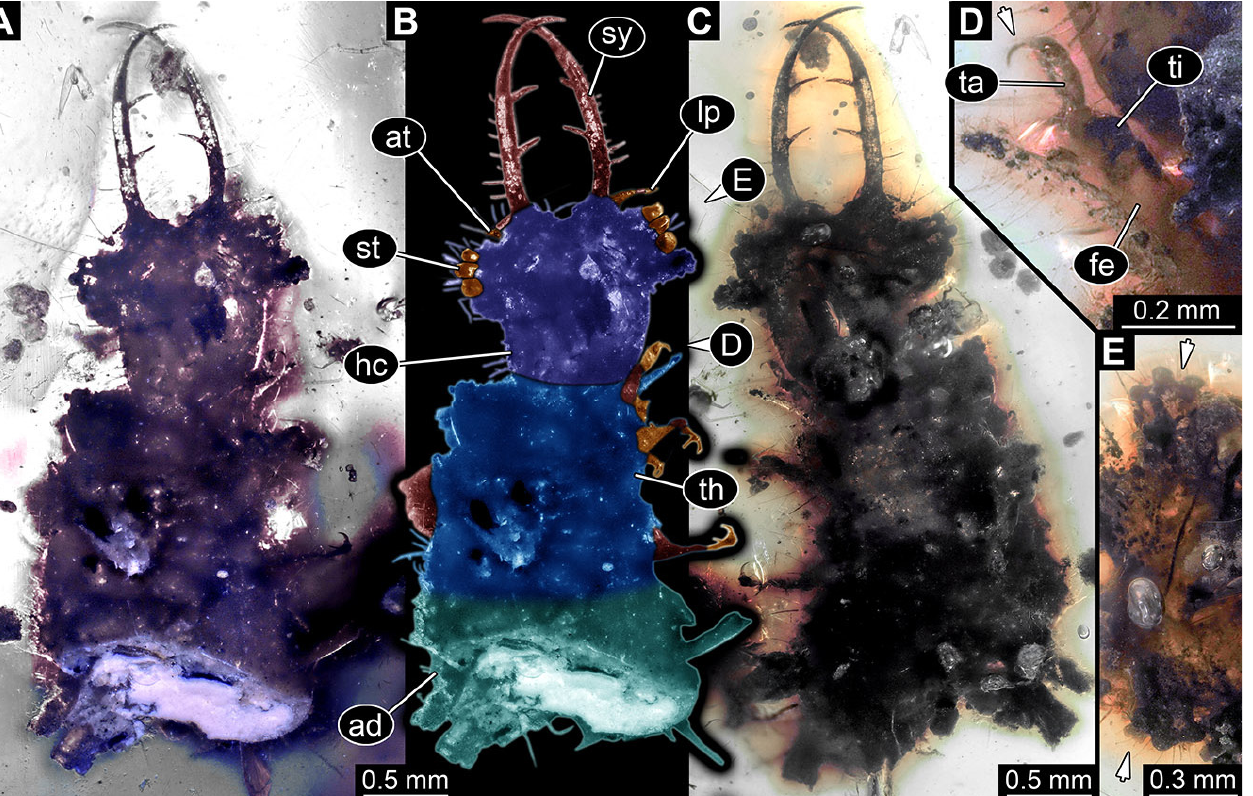
Figure 19. Fossil owllion larva, specimen 3232 (PED 0087), Cretaceous Kachin amber, Myanmar. ( A ) Overview, oblique ventral. ( B ) Color-marked version of ( C ). ( C ) Overview, oblique dorsal. ( D ) Close-up on locomotory appendage with claws (arrows). ( E ) Close-up on stylet. Abbreviations: ad = abdomen; at = antenna; fe = femur; hc = head capsule; lp = labial palp; ms = mesothorax; mt = metathorax; pt = prothorax; st = stemmata; sy = stylet; ta = tarsus; te = trunk end; ti = tibia.